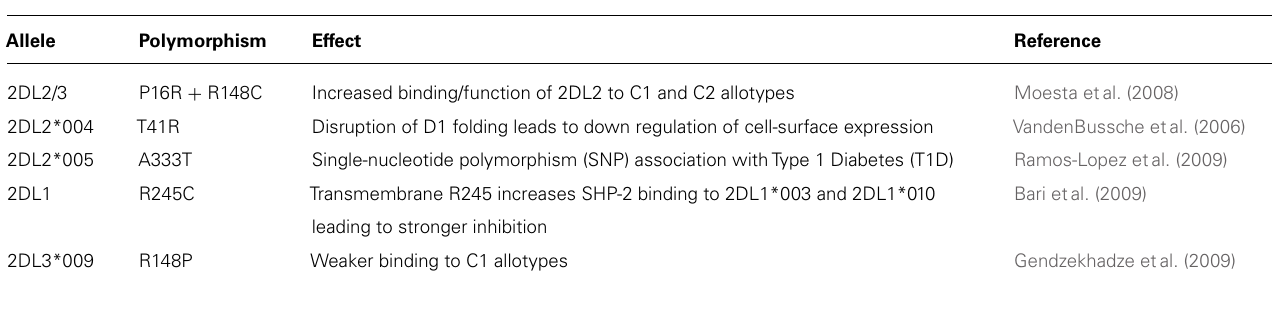
Table 5 | Functional effects of KIR